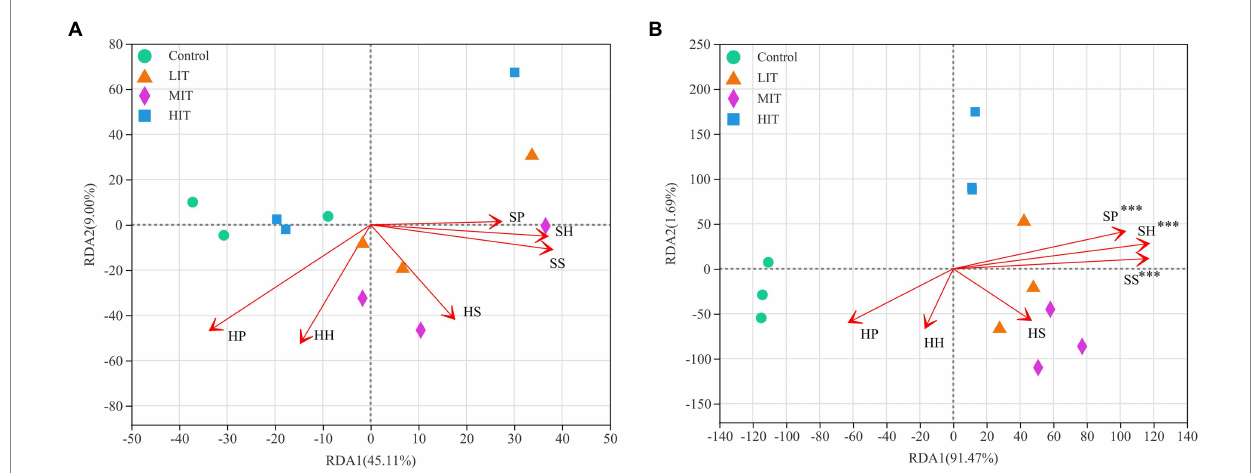
FIGURE 5 RDA of abundant bacterial (A) and fungal (B) communities at the genus level and understory vegetation characteristics for the soil samples from four thinning treatments in Cryptomeria japonica var. sinensis plantations. HH, HP, HS, SH, SP and SS denote the Shannon index, Pielou index and species richness in the herb and shrub layers, respectively. * p < 0.05, ** p < 0.01, *** p < 0.001.